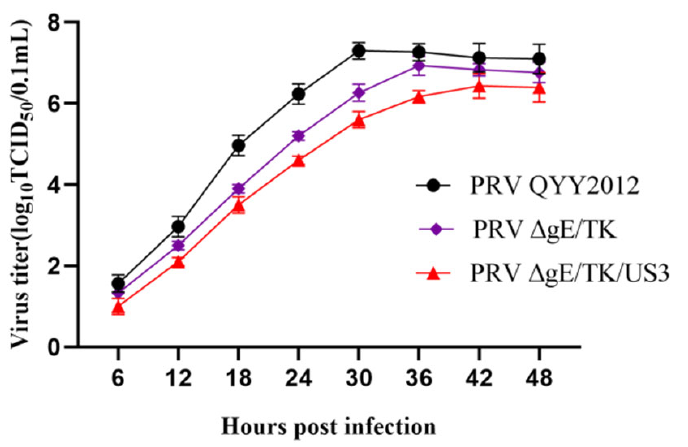
Figure 3. The multiple step growth curves of different PRV strains. Vero cells were inoculated with PRV QYY2012, PRV ∆ gE/TK, or PRV ∆ gE/TK/US3 strains. The cell culture supernatants were collected at different time points and used to calculate the TCID 50 of each virus.